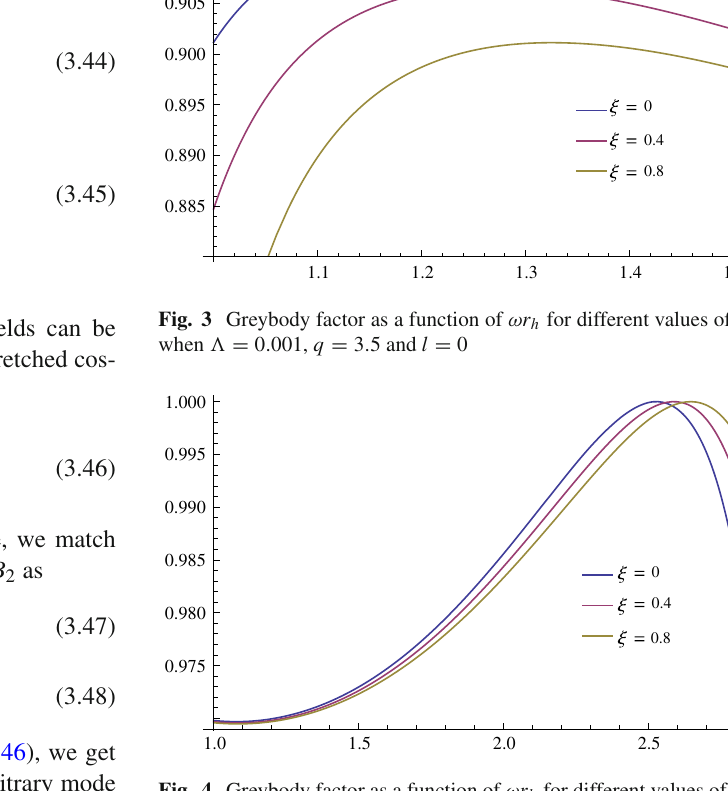
Fig. 4 Greybody factor as a function of ω r h for different values of ξ , when (cid:5) = 0 . 05, q = 3 . 5 and l = 0